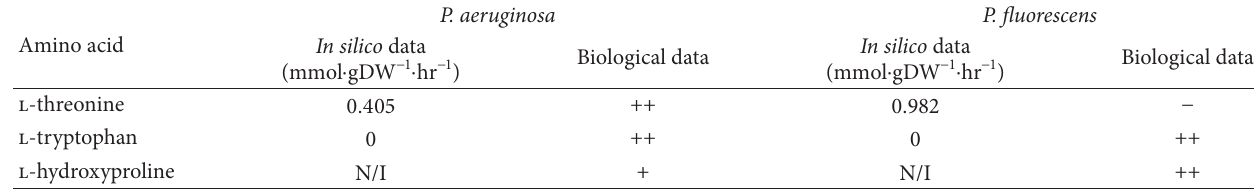
Table 3: Relative cell growth estimated visually from amount of growth on amino acid.